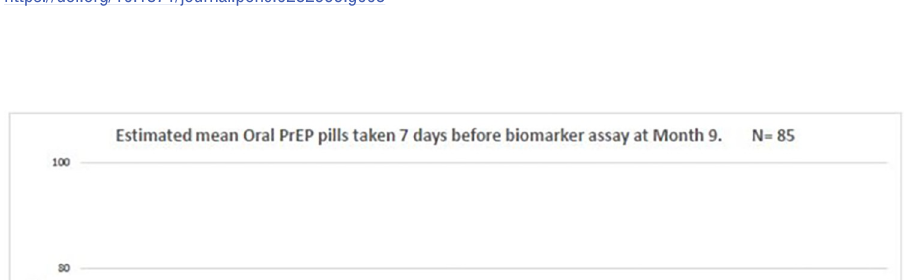
Fig 5. Estimated mean oral PrEP pills used a week before assay at Month 3.